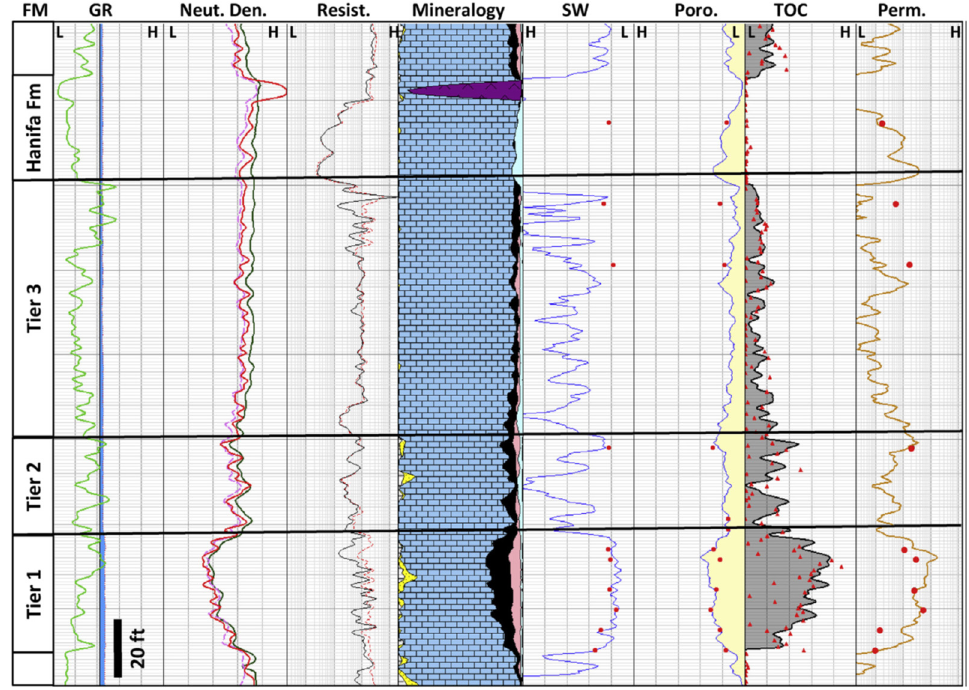
Figure 3. Three tiers in the Tuwaiq Mountain Formation (TWQ), as determined from wireline logs and core studies [17,18].